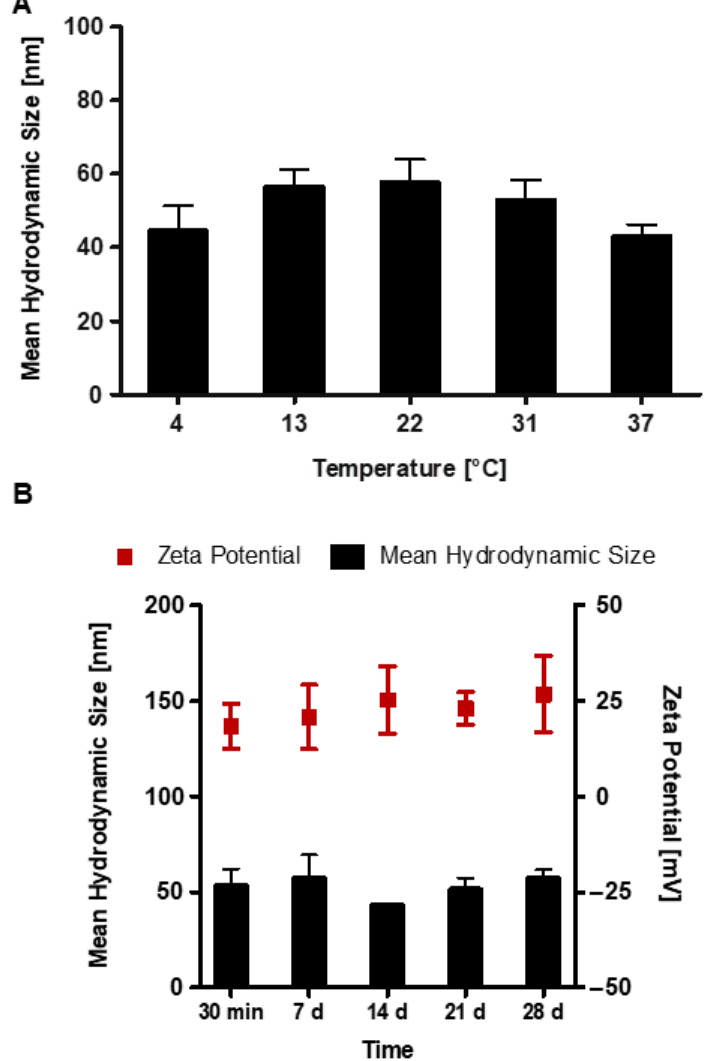
Figure 3. Characterization of RALA / α -TCP NP stability (mass ratio 5). ( A ) particle size remained stable when NPs were incubated over a temperature range of 4–37 ◦ C. ( B ) particle size and zeta potential of RALA / α -TCP NPs were consistent at room temperature over 28 days, i.e., the average particle size was ≈ 50 nm and ≈ + 25 mV in charge. (N = 3 ± SEM).